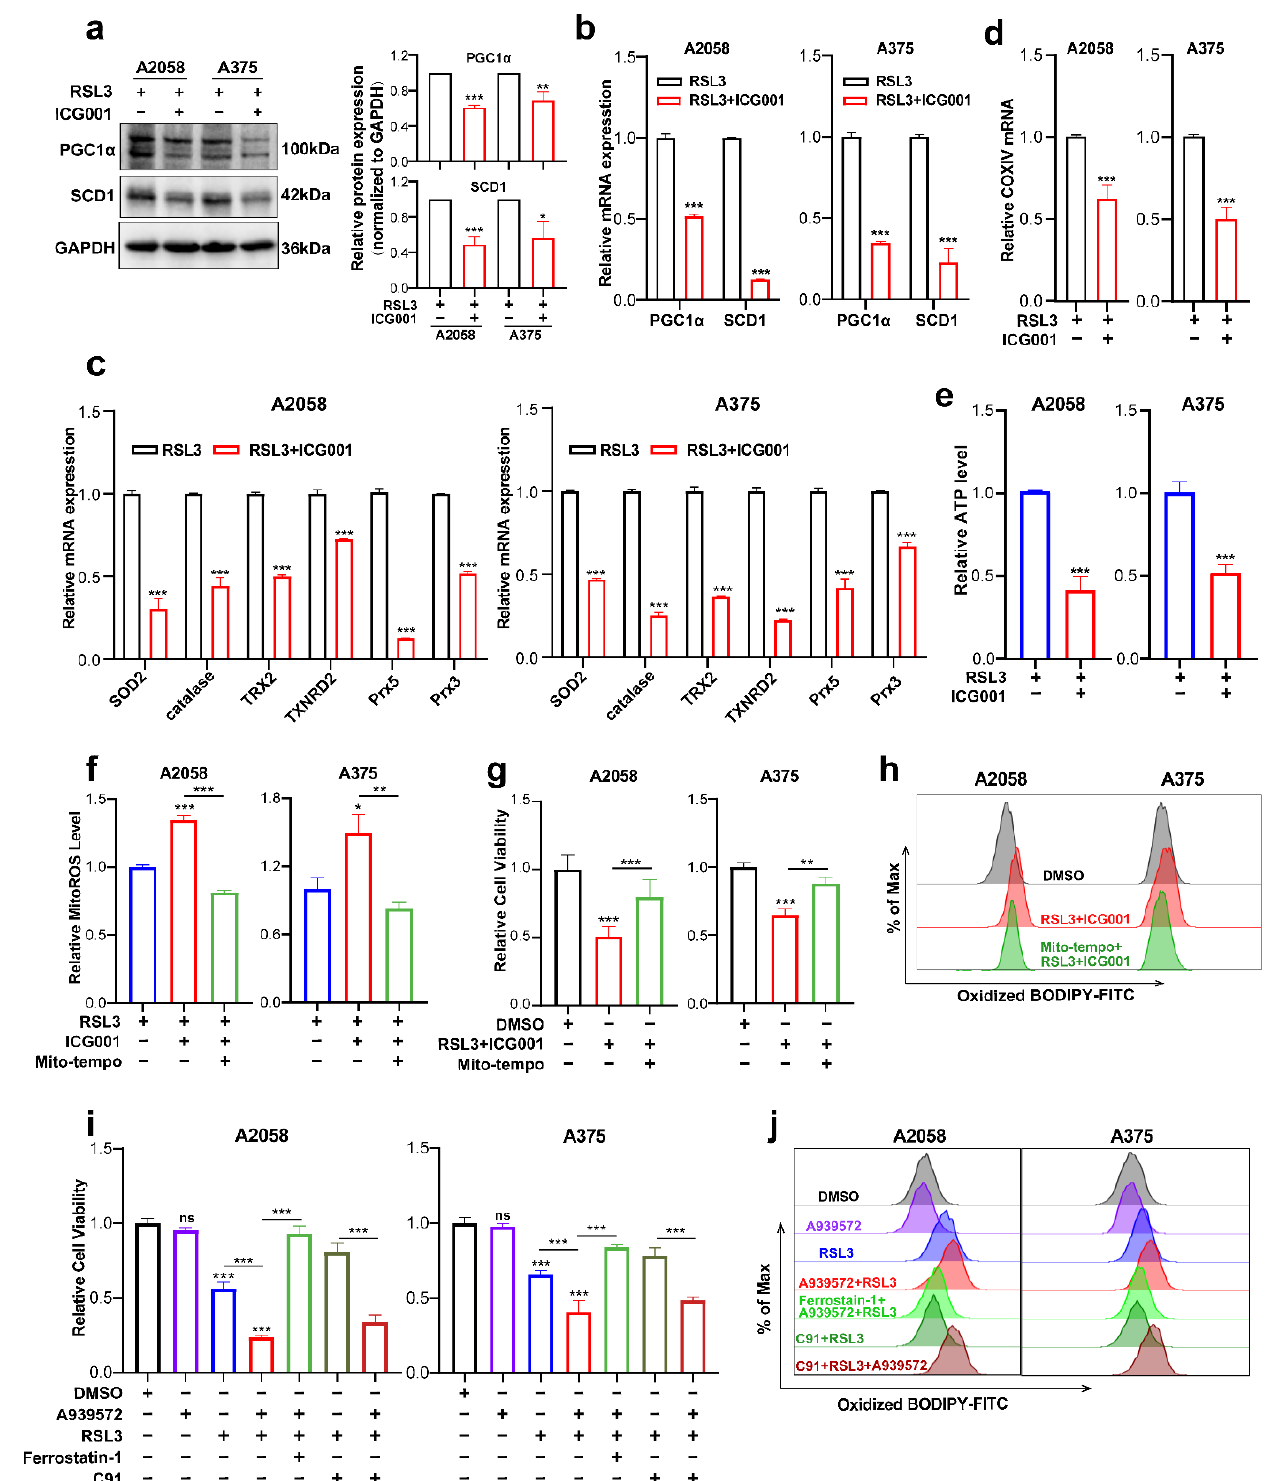
Figure 5. PGC1 α and SCD1 are two main effectors downstream of the Wnt/ β -catenin-MITF pathway in melanoma cell ferroptosis. ( a , b ) Immunoblotting and qRT-PCR analysis of PGC1 α and SCD1 levels in the melanoma cells between the RSL3 monotreatment group and RSL3 plus ICG001 combined treatment group (RSL3, 2 µ M for A2058 and 0.5 µ M for A375 for 24 h. 6 µ M ICG001 for both A2058 and A375 for 24 h). ( c , d ) qRT-PCR analysis of a panel of antioxidant enzymes and COXIV in the melanoma cells with the indicated treatment for 24 h (RSL3, 2 μM for A2058 and 0.5 μM for A375 ; 6 μM ICG001 for both A2058 and A375). ( e , f ) The level of mitoROS and intracellular ATP in A2058 and A375 with the indicated treatment for 24 h (RSL3, 2 μM for A2058 and 0.5 μM for A375 ; 6 μM